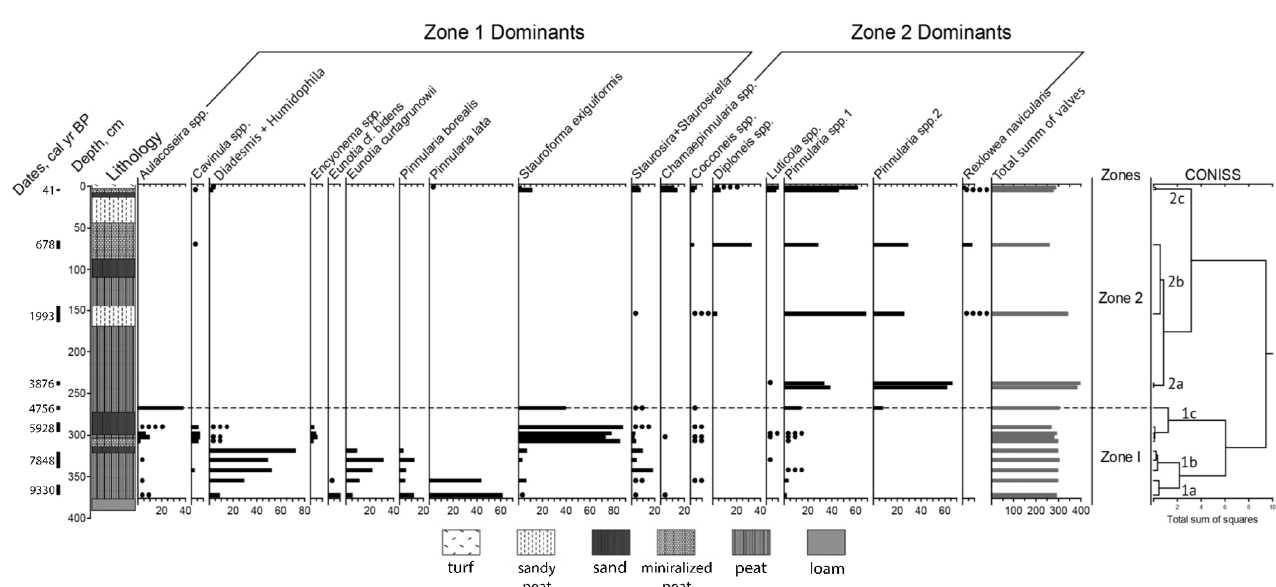
Figure 4. Stratigraphic profiles based on diatom analysis (relative abundance, %) and CONISS clustering results. Dashed line marks boundary between Zone 1 and Zone 2 (at 265 cm), areas of gray color mark layers of sand with no diatom valves found. Five or less valves in a layer are marked with dots, while the more abundant valves are marked with